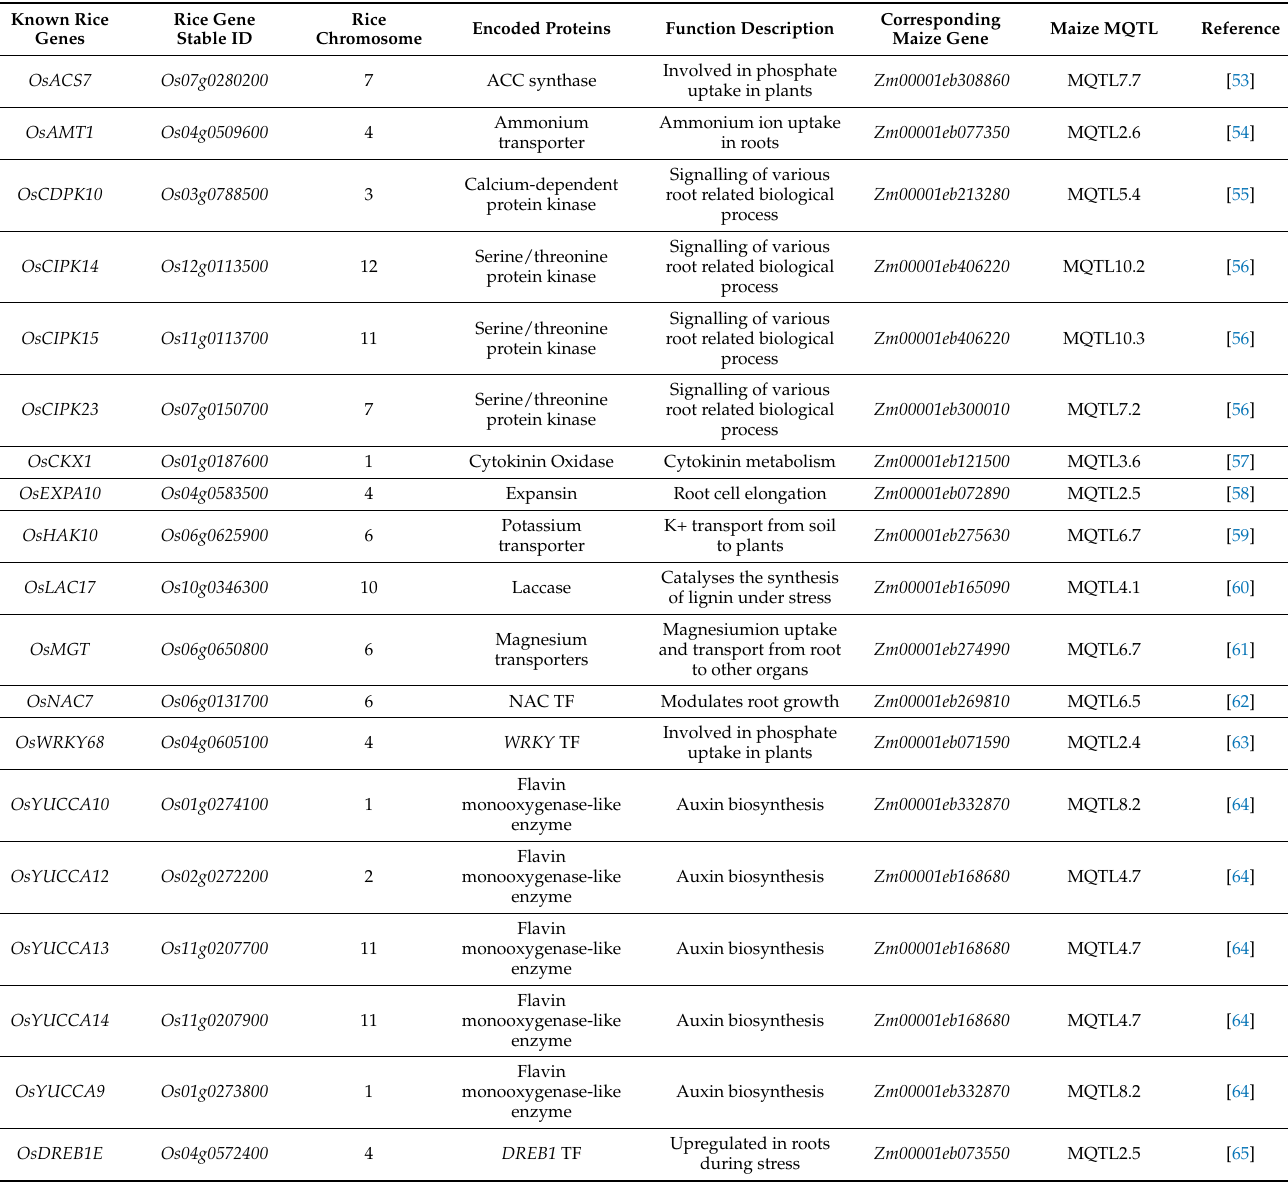
Table 3. Rice genes and their orthologs within MQTL regions associated with different root